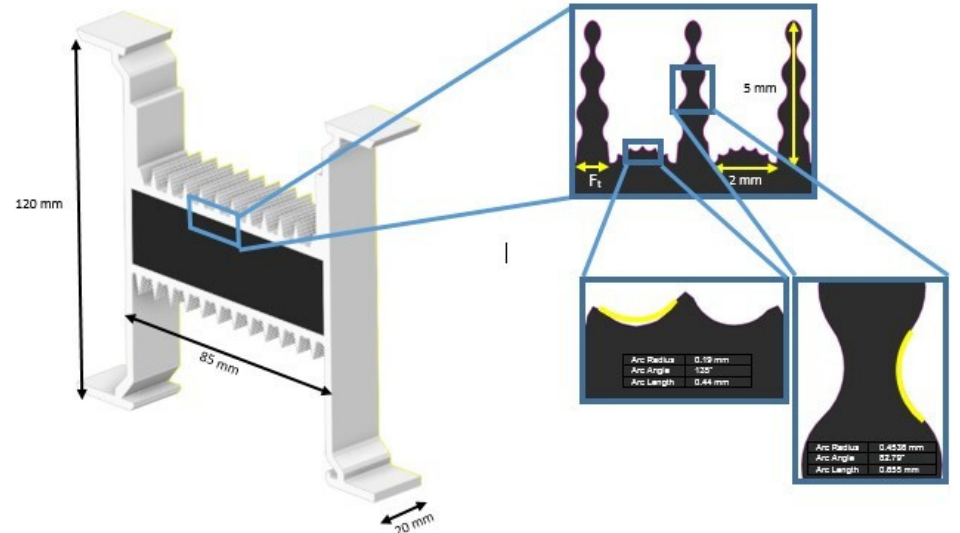
Figure 1. Detailed dimension and geometrical setup of bus duct conductor.